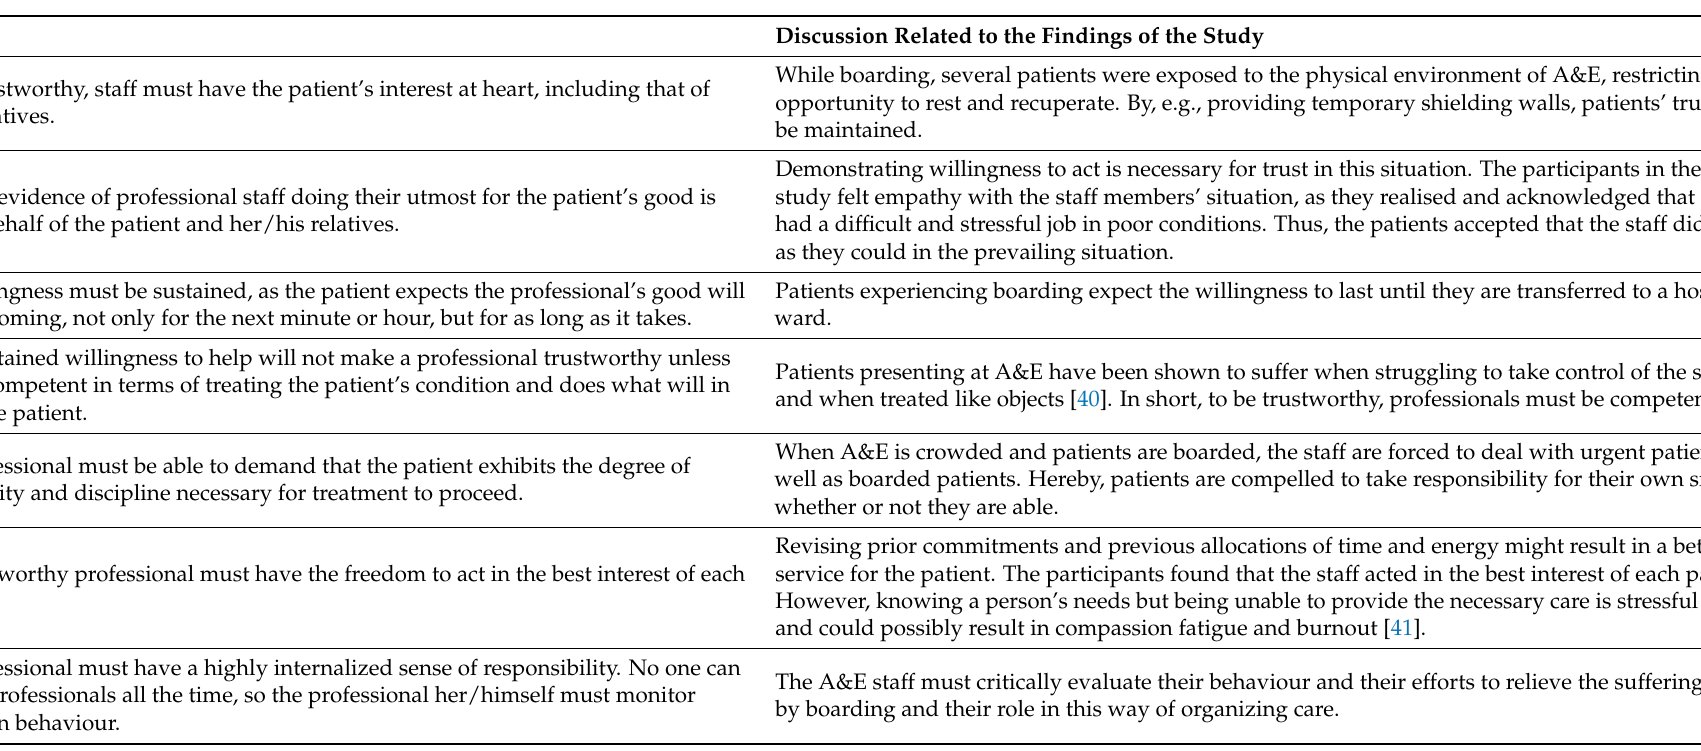
Table 4. The seven conditions for professional authority described by